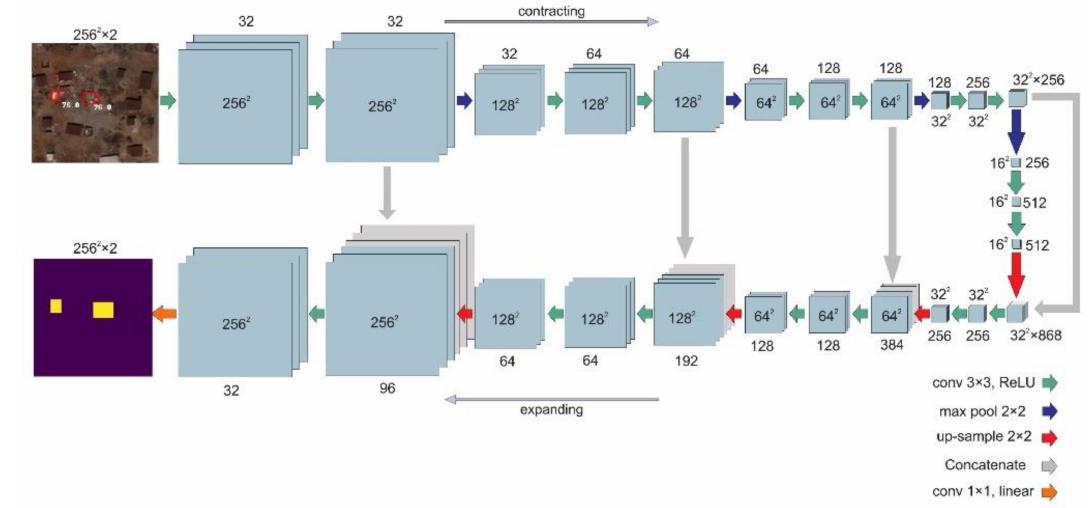
Figure 2. The U-Net style convolutional neural networks used in this study. The input patch size to the network in our study is 256 by 256 pixels. As shown in this example, the building footprints are used to mask the image. The purple portion of the image is not used in training the